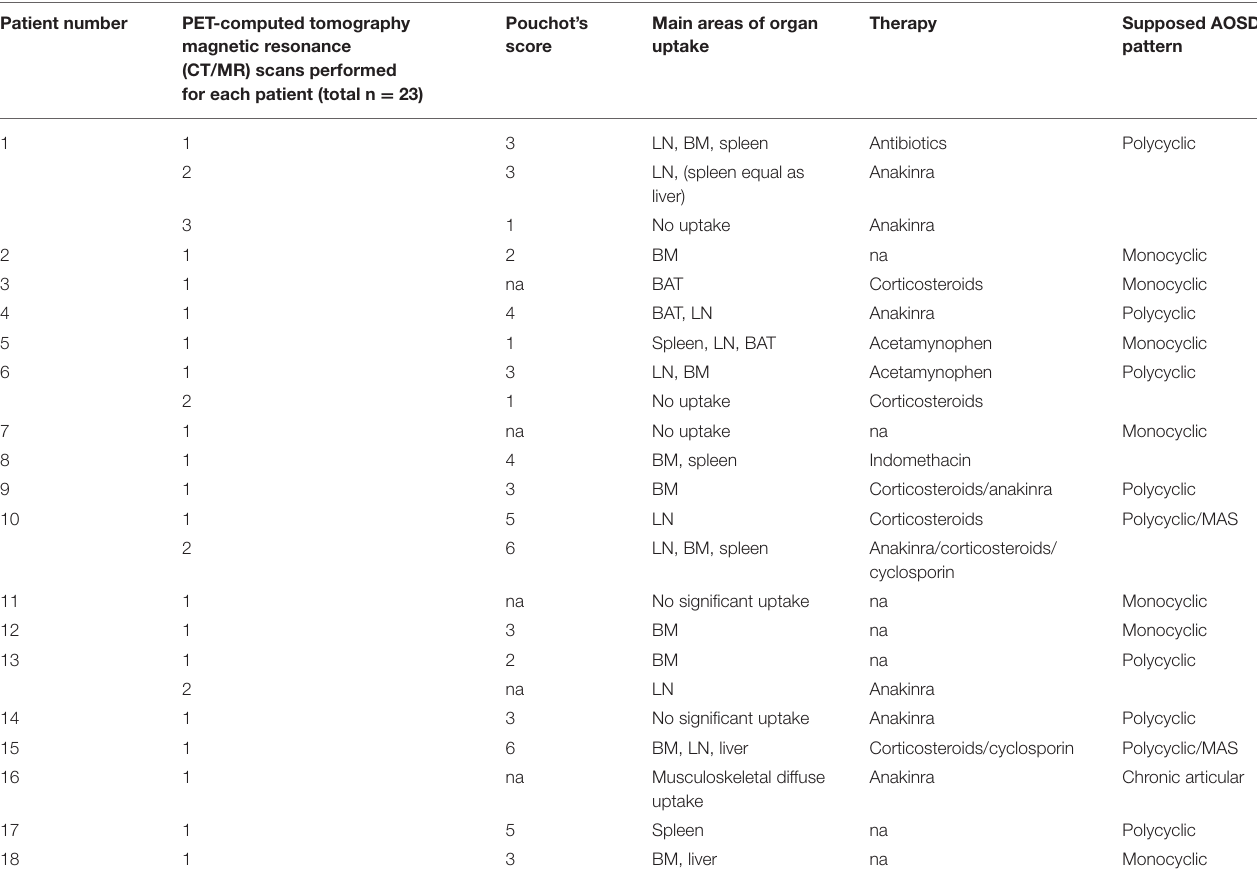
TABLE 1 | Characteristics of adult-onset Still’s disease (AOSD) patients, main areas of uptake represented at positron emission tomography (PET) scans, and type of therapy undertaken at time of scan. Patient number PET-computed tomography magnetic